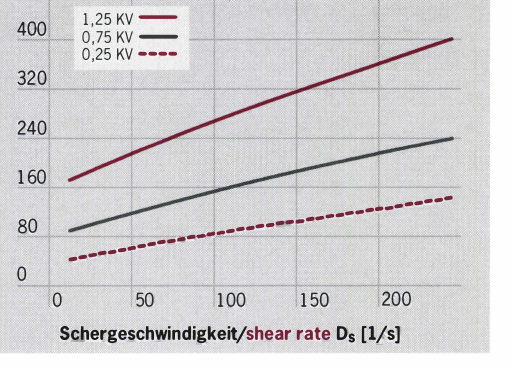
Fig. 3: Viscosity curves of electro­ rheological fluid ERFl at various applied electric field